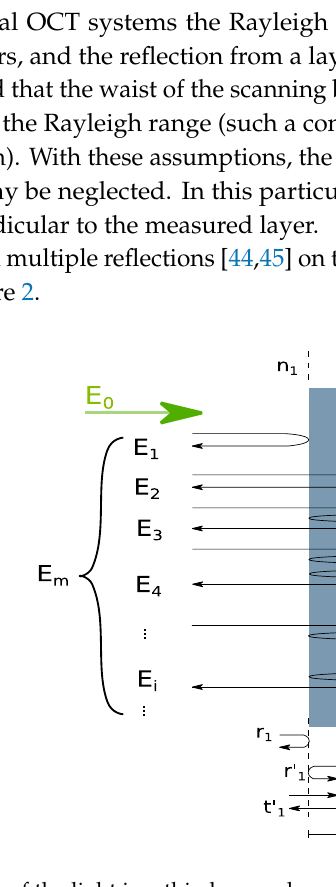
Figure 2. The propagation of the light in a thin layer, where E 0 and E m are complex amplitudes of the incident and reflected beams, respectively. E m equals the sum of complex amplitudes of the reflected waves E 1 , E 2 , …, E i , … from the thin layer. The amplitudes E i depend on the transmission coefficients t 1 and t ’ 1 and reflection coefficients r 1 , r ’ 1 , and r 2 . These coefficients depend on the layer thickness d , the refractive index of the layer n 2 , and the refractive indexes of the media in front and behind the layer: n 1 and n 3 .